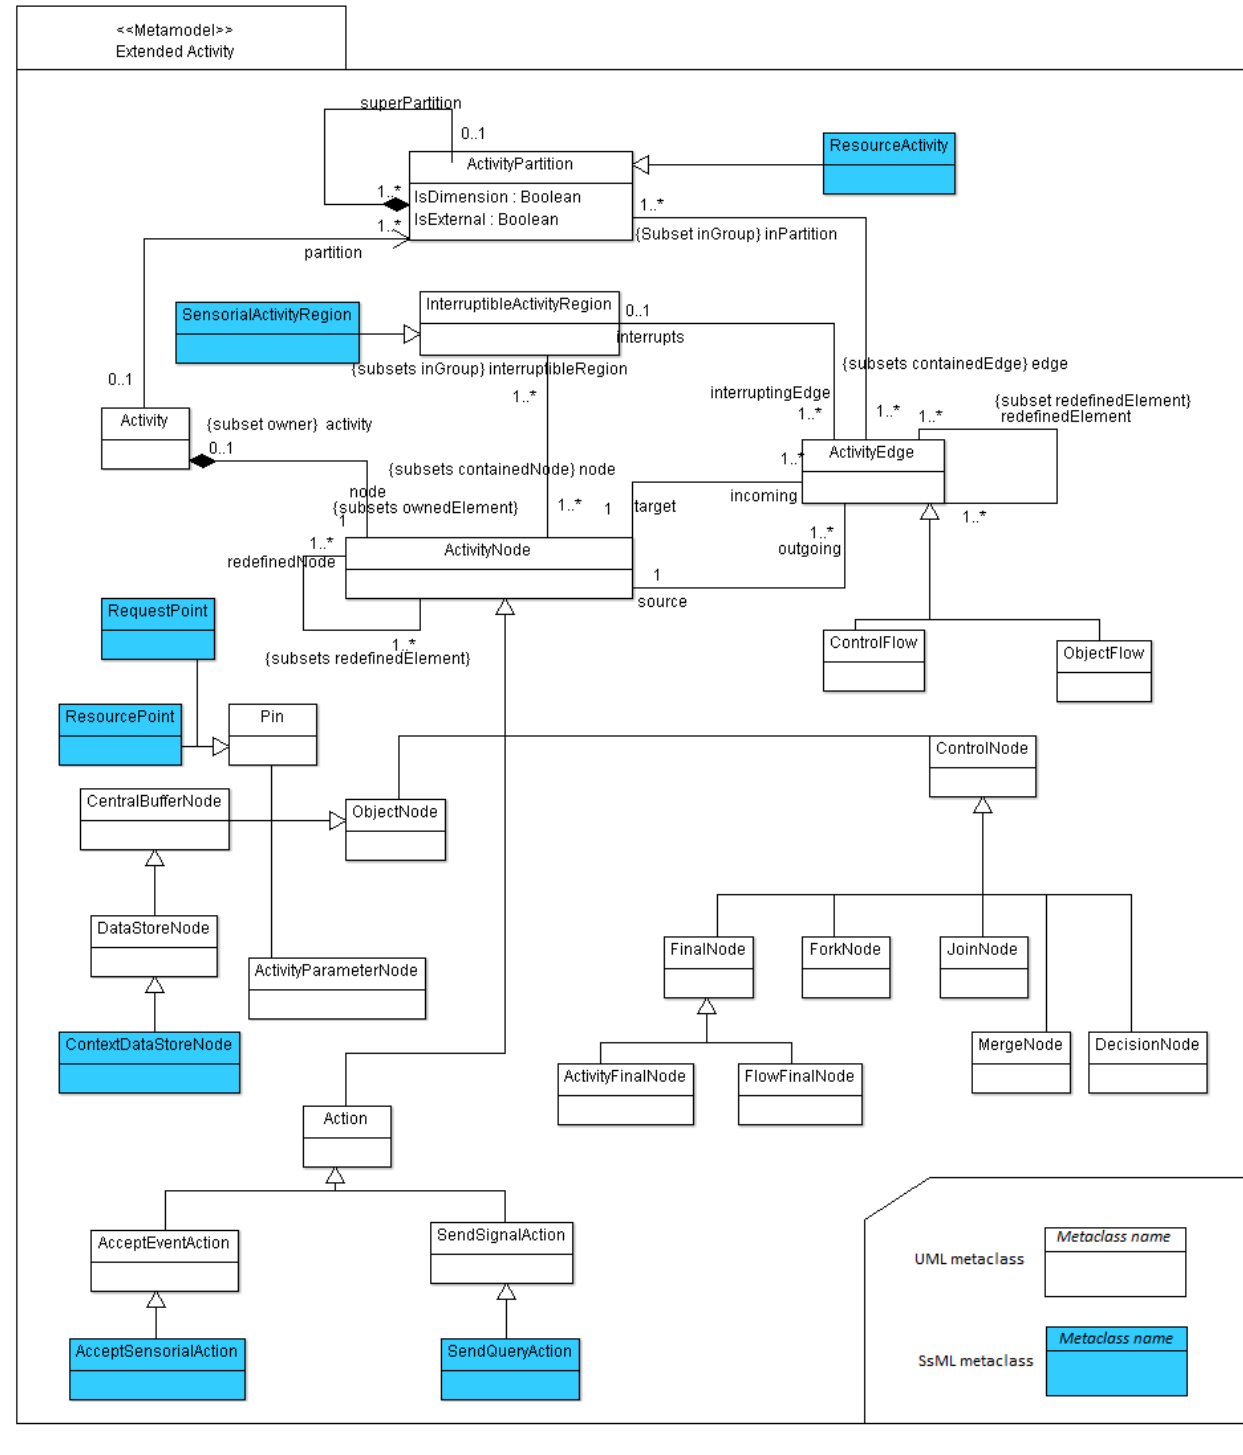
Figure 2. Part of the SsML profile focusing on the extension of behavioral packages of UML